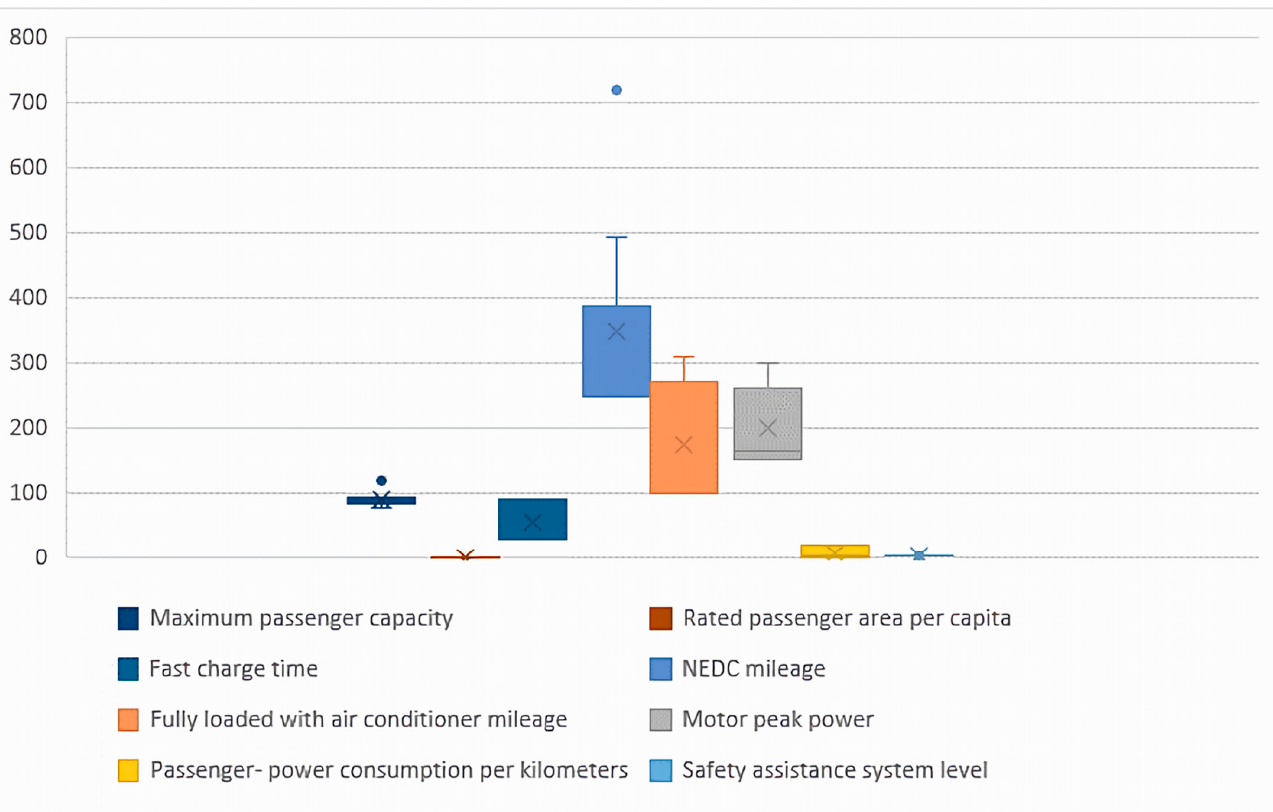
Figure 4. Boxplots of each evaluation